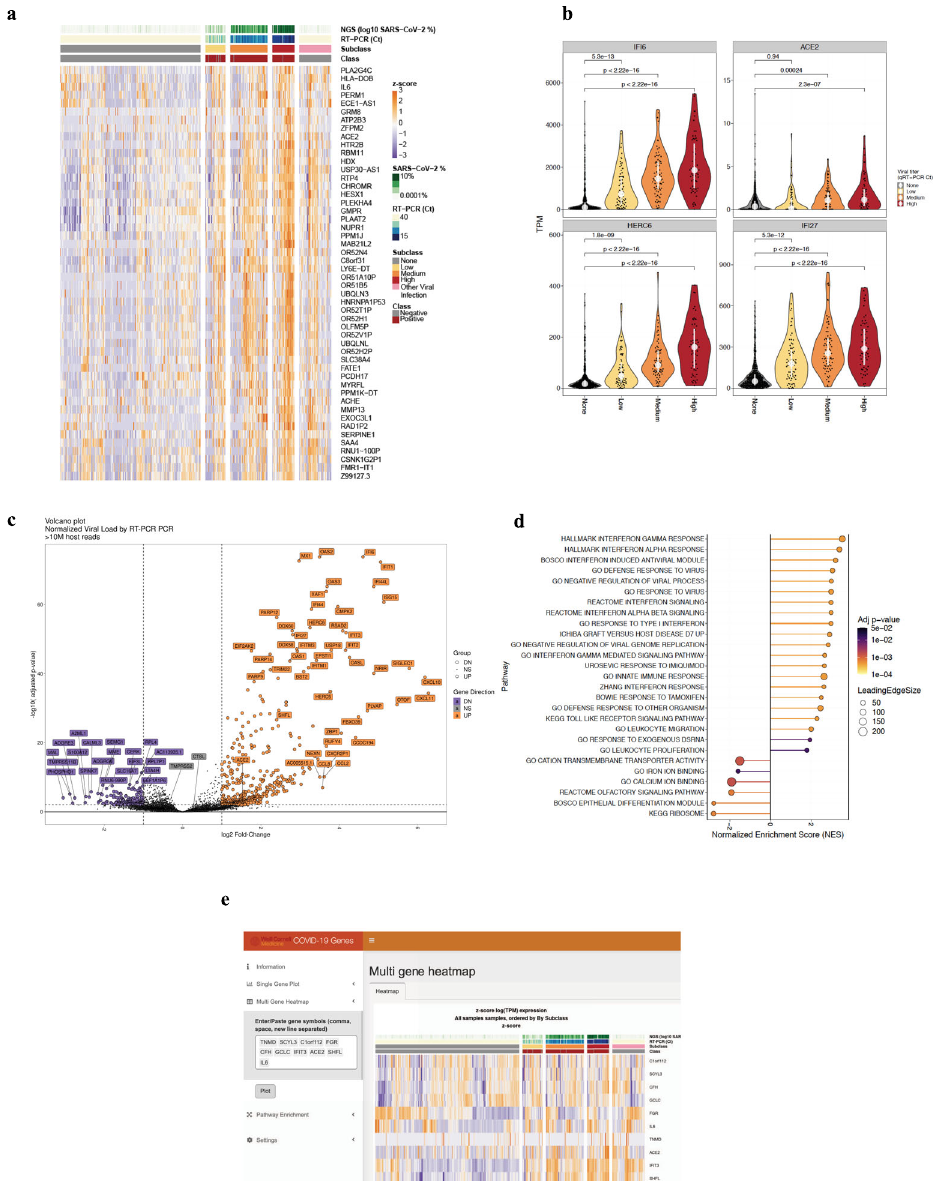
Fig. 4 Host transcriptome responses to SARS-CoV-2. a Samples were quanti fi ed by RNA-seq (log 10 SARS-CoV-2% of reads), and qRT-PCR (Ct values) to create a three-tier range of viral load for the positive samples (class, red) and those samples with other viral infections that were SARS-CoV-2 negative (gray). Differentially expressed genes showed upregulated (orange) genes as well as downregulated (purple) genes compared to non-viral samples. b Upregulated genes, with violin plots for all samples, include IFI6 , ACE2 , SHFL , HERC6 , IFI27 , and IFIT1 , based on data from ( c ), which is the total set of DEGs, shown here as a volcano plot, with a core set of upregulated genes (orange) distinct from the set of downregulated genes (purple), compared to genes that are not signi fi cantly differently expressed (gray) in any comparison (Statistical tests by negative binomial model in DESeq2, multiple testing adjusted p value < 0.01, |logFC| >0.58). d GSEA enrichment of signi fi cant pathways, with color indicating statistical signi fi cance and circle size the number of genes on the leading edge. e Screenshot of the WCM COVID-19 Genes Portal, an interactive repository for mining the human gene expression changes in the data from this study